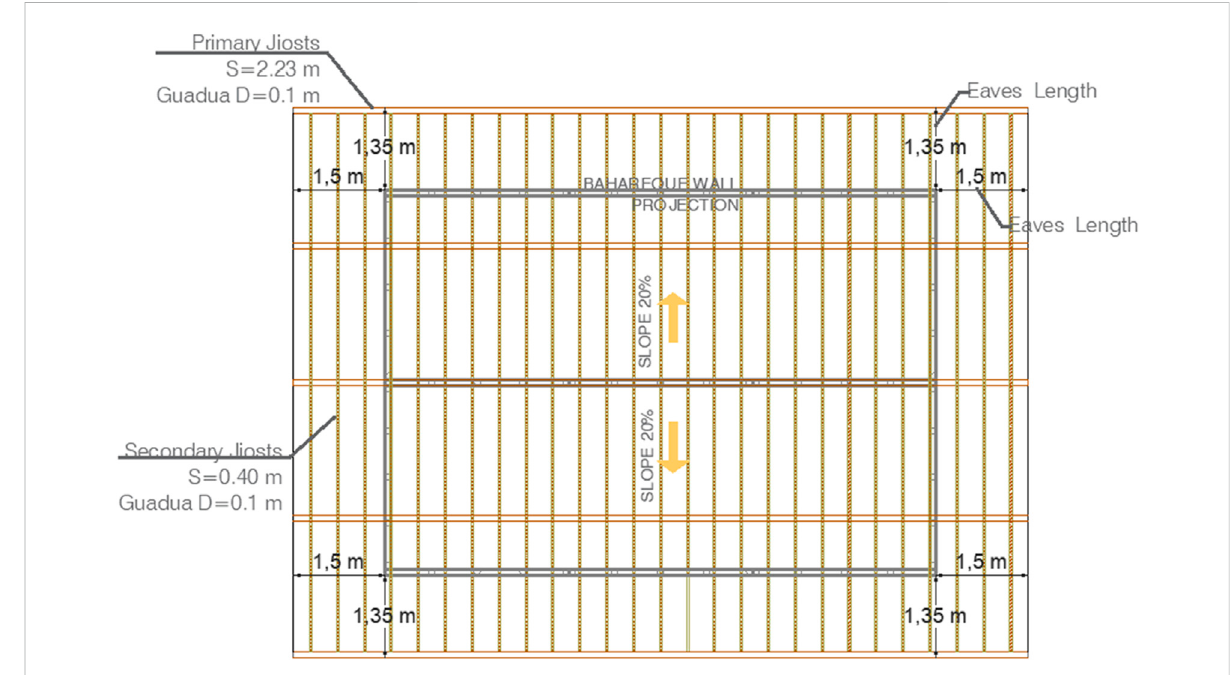
FIGURE 7 Roof Model. Design inspired by the publication by López-Muñoz (2015).